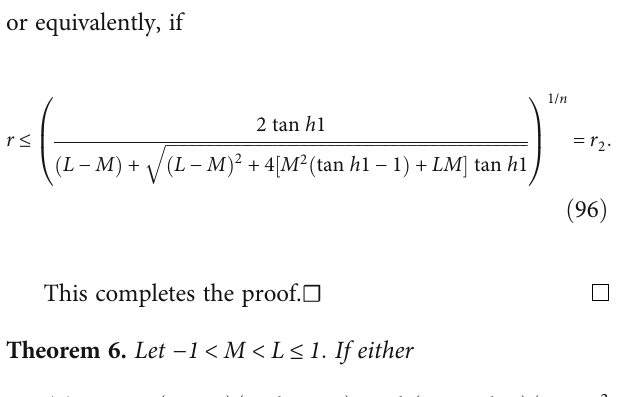
ffiffiffiffiffiffiffiffiffiffiffiffiffiffiffiffiffiffiffiffiffiffiffiffiffiffiffi